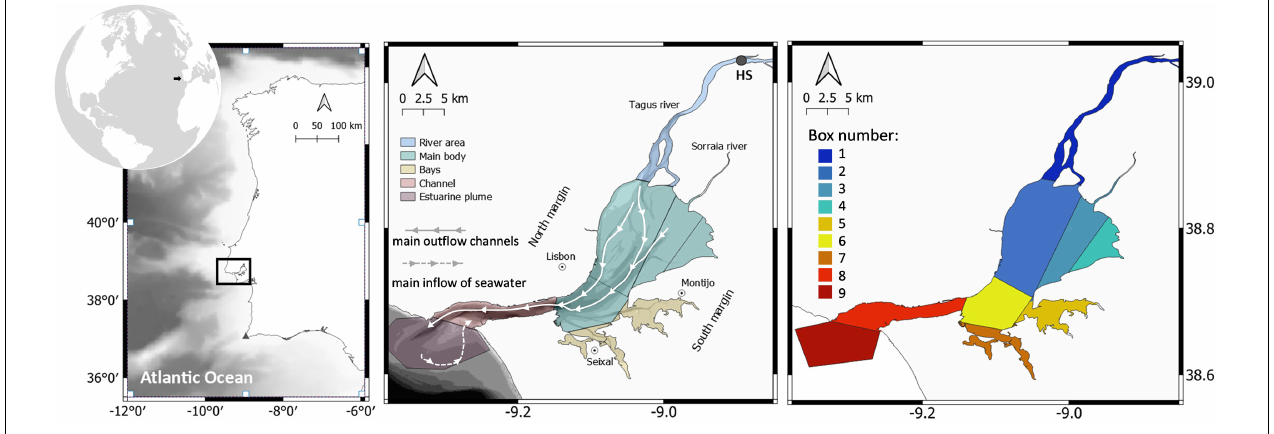
FIGURE 1 | Maps showing the TagusROFI (square; left) ; Designations used in the present work and bathymetry–darker colors represent higher depths (middle) ; and boxes used to calculate residence time, exposure time and integrated water fraction (right) . HS–Hydrological